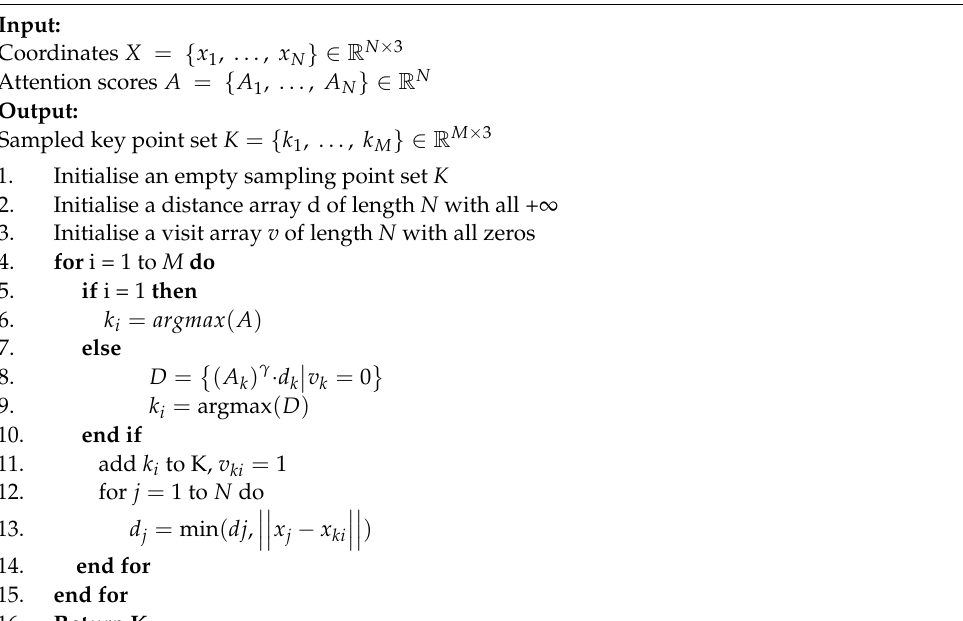
Algorithm 1: Attention-guided farthest point sampling algorithm. N is the number of input points and M is the number of output points sampled by the